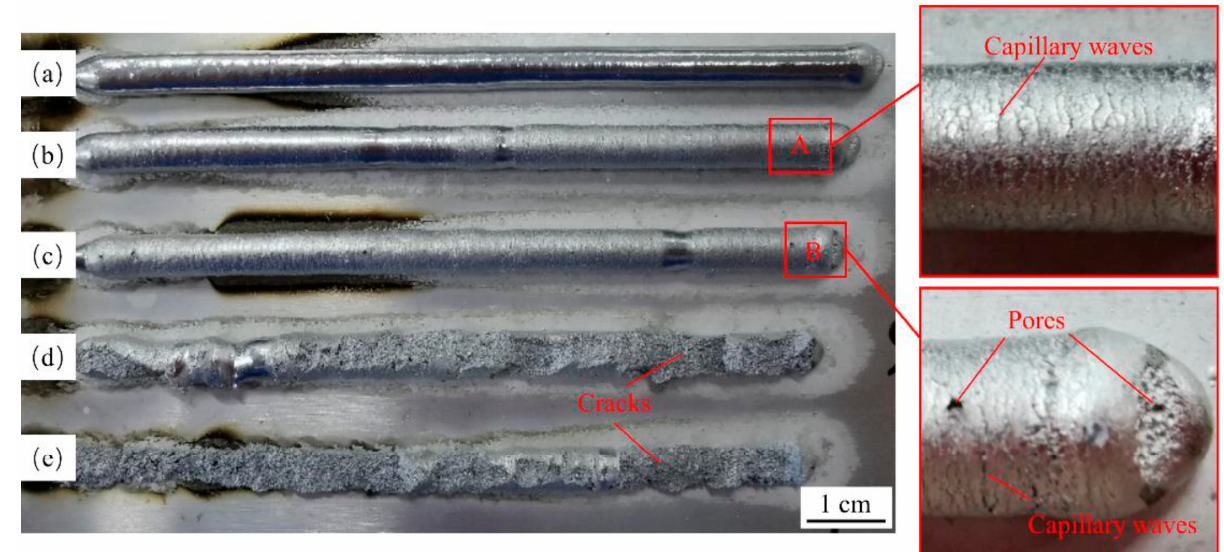
Figure 8. Effect of different ultrasonic amplitudes on weld: ( a ) sample 1; ( b ) sample 2; ( c ) sample 3; ( d ) sample 4; ( e ) sample 5, reproduced or adapted from [81], with permission from MDPI, 2022.